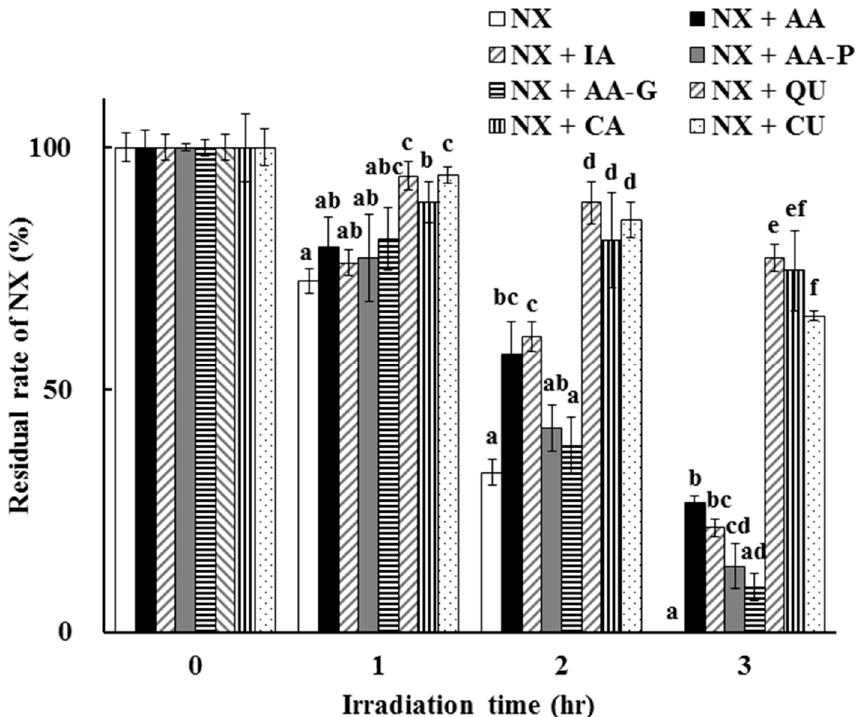
Figure 6. Photoprotective effect of 100 µmol/L selected antioxidants on NX photodegradation in a solution. The values represent the mean ± S.D. ( n = 3). a–f Means without a common superscript are significantly different ( p < 0.05). Isoascorbic acid (IA), L-ascorbic acid-2-phosphate trisodium (AA-P), L-Ascorbic acid-2-glucoside (AA-G), quercetin (QU), catechin (CA) and curcumin (CU). Table 1. Photoprotective e ff ects and antioxidative activities of selected antioxidants. Residual Rate of NX Residual Rate of Kinetics Constant of after UV Irradiation Antioxidants after UV for 3 h Irradiation for 3 h